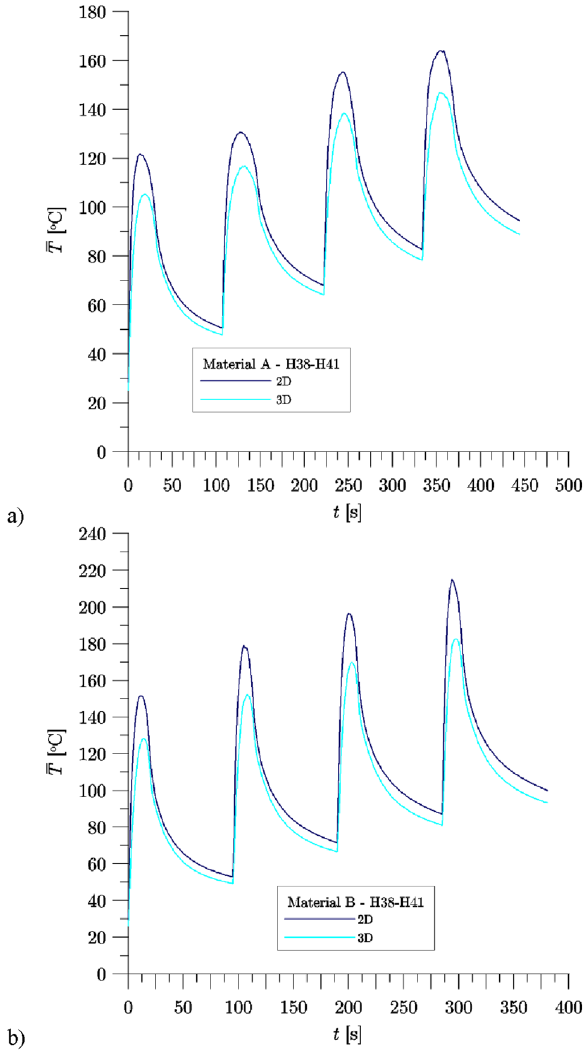
Figure 10. Changes of temperature on the wheel tread during braking H38–H41—results of numerical calculations for 2D axisymmetric and 3D models: ( a ) Material A, ( b ) Material B.